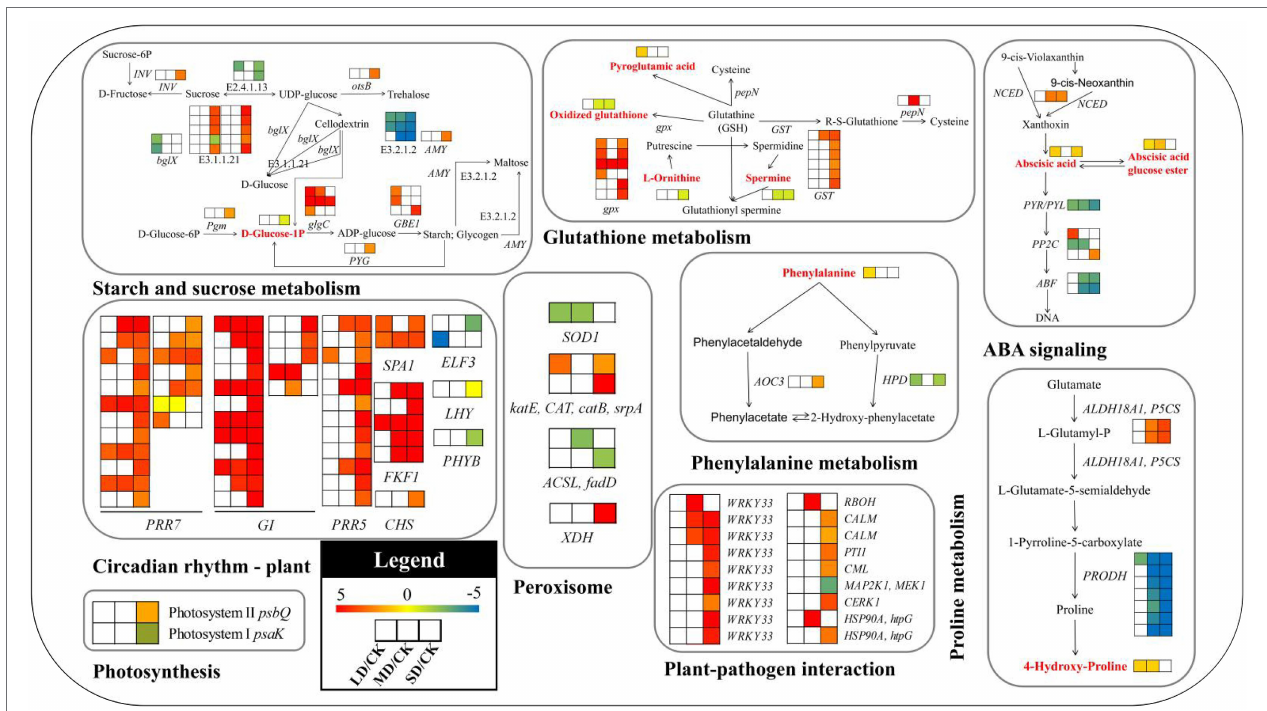
FIGURE 9 | Key metabolic pathways and candidate genes in S. davidii associated with the three treatment groups under drought stress. E3.2.1.2 , beta-amylase; E2.4.1.13 , sucrose synthase; E3.1.1.11 , pectinesterase; E3.2.1.21 , beta-glucosidase; glgC , glucose-1-phosphate adenylyltransferase; GBE1 , 1,4-alpha-glucan branching enzyme; bglX , beta-glucosidase; Pgm , phosphoglucomutase; PYG , glycogen phosphorylase; INV , beta-fructofuranosidase; AMY , alpha-amylase; otsB , trehalose 6-phosphate phosphatase; gpx , glutathione peroxidase; pepN, aminopeptidase N; GST , glutathione S-transferase; PP2C , protein phosphatase 2C; PYL , abscisic acid receptor PYR/PYL family; ABF , ABA-responsive element binding factor; NCED , 9-cis-epoxycarotenoid dioxygenase; PRR7 , pseudoresponse regulator 7; PRR5 , pseudoresponse regulator 5; SPA1 , protein suppressor of PHYA-105 1; ELF3 , protein EARLY FLOWERING 3; CHS , chalcone synthase; FKF1 , flavin- binding kelch repeat F-box protein 1; GI , GIGANTEA; LHY , MYB-related transcription factor LHY; PHYB , phytochrome B; SOD1 , superoxide dismutase; katE, CAT, catB, srpA , catalase; ACSL, fadD , long-chain acyl-CoA synthetase; XDH , xanthine dehydrogenase/oxidase; HPD , 4-hydroxyphenylpyruvate dioxygenase; AOC3 , primary-amine oxidase; PRODH , proline dehydrogenase; ALDH18A1, P5CS , delta-1-pyrroline-5-carboxylate synthetase; HSP90A, htpG , molecular chaperone HtpG; WRKY33 , WRKY transcription factor 33; RBOH , respiratory burst oxidase; CALM , calmodulin; PTI1 , pto-interacting protein 1; CML , calcium-binding protein; MAP2K1, MEK1 , mitogen-activated protein kinase kinase 1; CERK1 , chitin elicitor receptor kinase 1; psbQ , photosystem II oxygen-evolving enhancer protein 3; and psaK , photosystem I subunit X. The log 2 [fold-change (FC)] colour scale ranges from − 5 to 5, with blue indicating downregulation and red indicating upregulation (see the colour set scale in the bottom left corner). The red characters represent the metabolites in the pathway